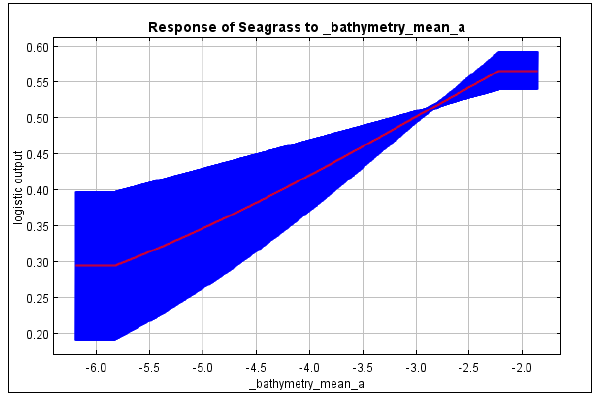
Figure 8. Response curves of mean bathymetry for the seagrass habitat suitability model.